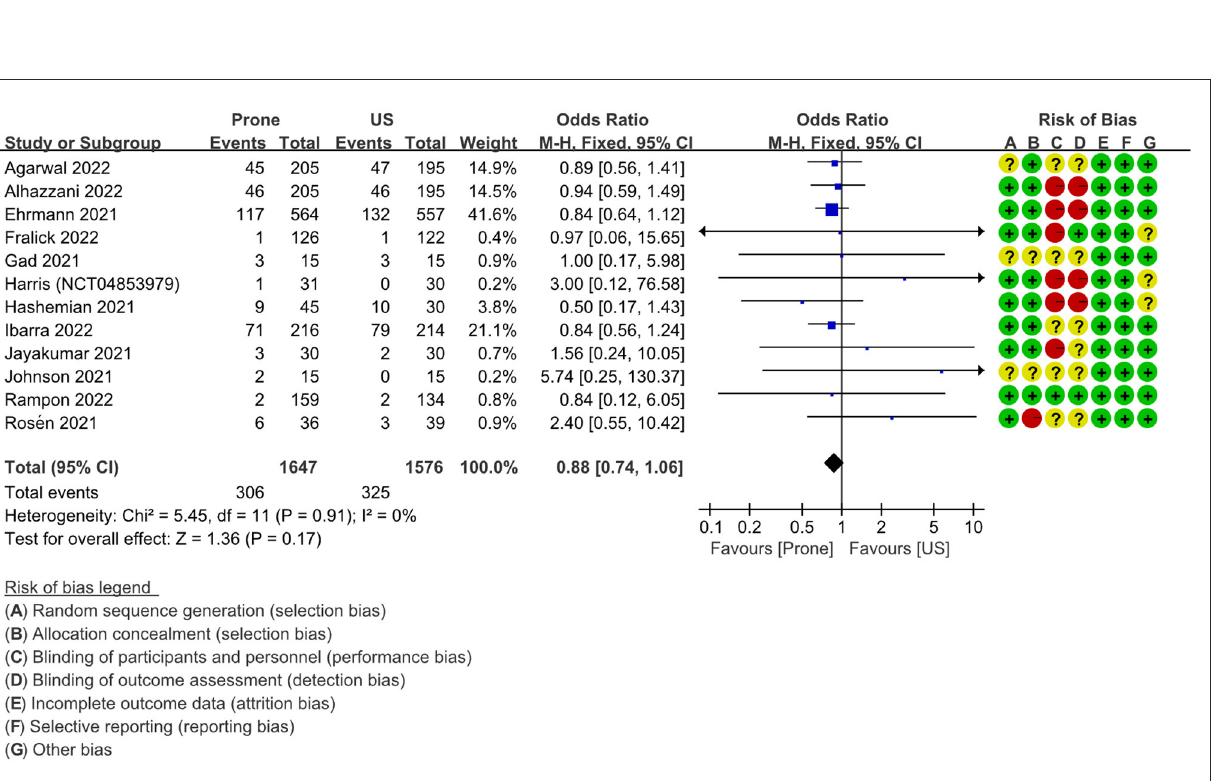
FIGURE5 Secondary outcome: forest plot of mortality in fixed effects model. US, usual care; M–H, Mantel–Haenszel; CI, confidence